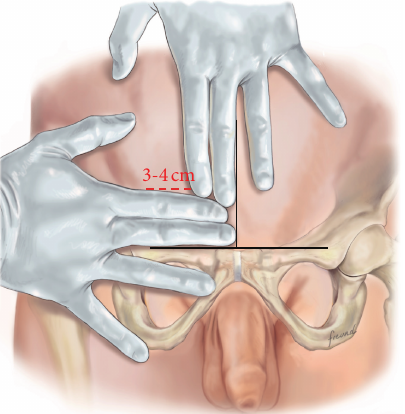
Figure 3: The external aponeurosis is incised to expose the under- lying internal